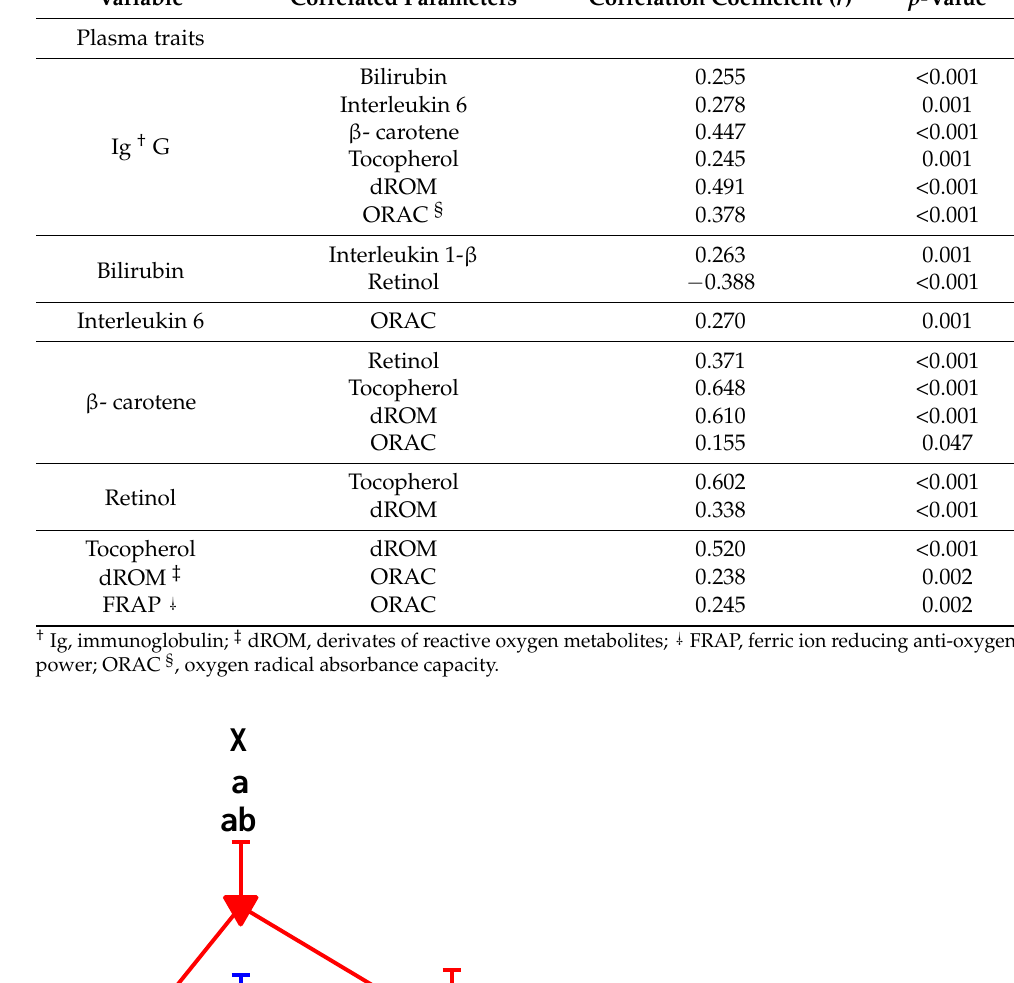
Table 3. Correlations between selected plasma variables.